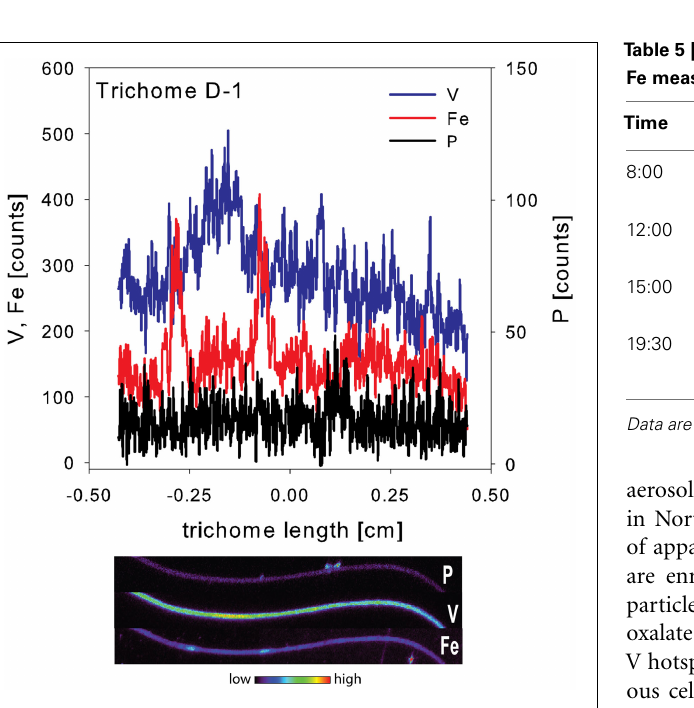
FIGURE 11 | Light micrographs and false-color element (P, S,V, and Fe) maps of a Trichodesmium trichome. The color scale for element maps is shown, with warmer colors indicating higher element concentrations.The location of the analyzed trichome section is indicated on the light micrograph in red (V-1).This map was recorded at GSECARS.